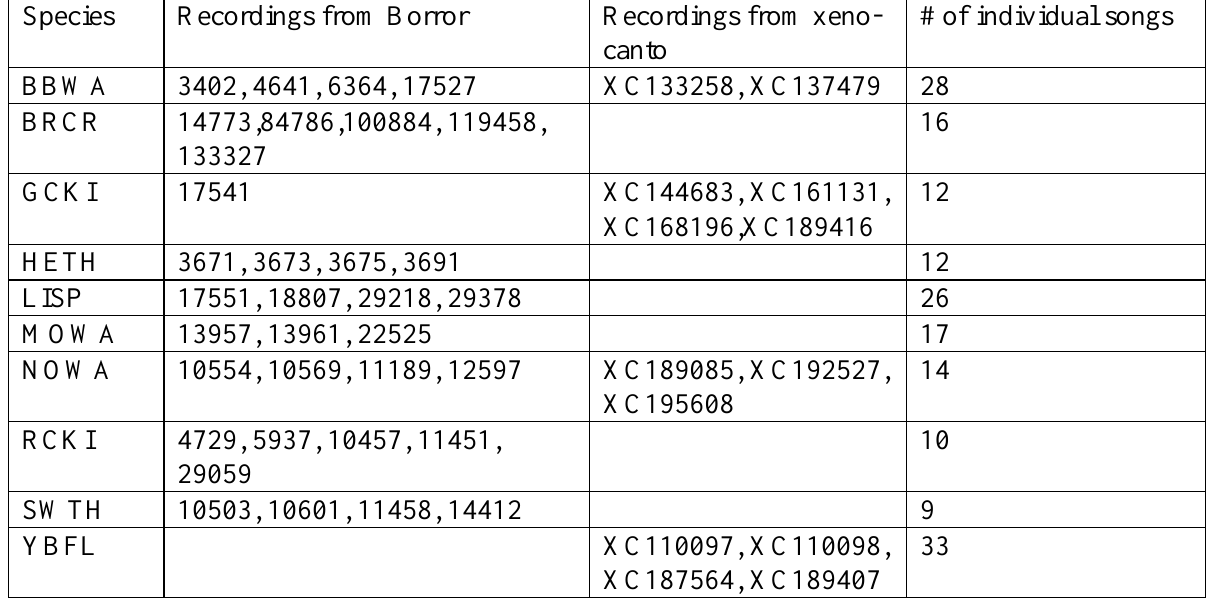
Table A1.1: Source of training data for song recognizers.